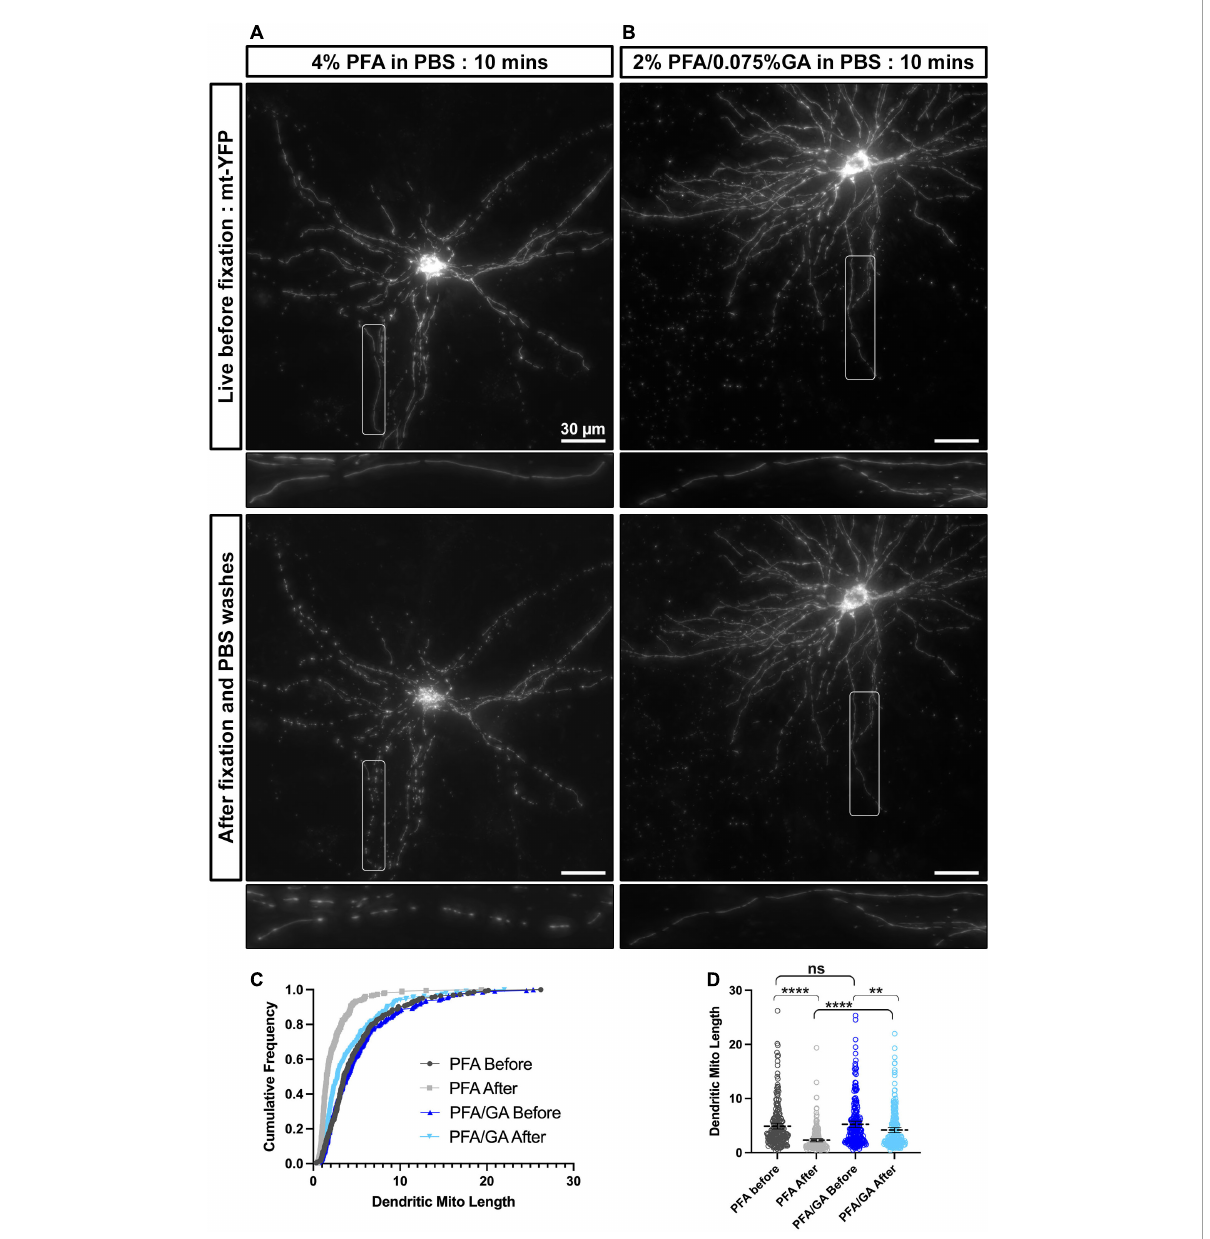
FIGURE1 A combination of PFA and GA maintains mitochondria morphology better than PFA alone in cultured cortical neurons. (A) A representative neuron labeled with mitochondrial matrix targeted YFP (mt-YFP) imaged live before fixation (top) and after fixation with 4% PFA in PBS (bottom) . (B) A representative neuron labeled with mt-YFP imaged live before fixation (top) and after fixation with 2% PFA/0.075% GA in PBS (bottom) . (C) Cumulative frequencies of dendritic mitochondrial length showing that fixation with PFA only results in fragmentation of mitochondria. (D) Quantification of dendritic mitochondrial lengths shown as mean ± 95% CI before and after fixation with the indicated fixative solution. Kruskal–Wallis test with Dunn’s multiple comparisons test. n 4%PFAbefore = 2 cultures, 16 dendrites, 225 mitochondria, n 4%PFAafter = 2 cultures, 16 dendrites, 227 mitochondria, n PFA / GAbefore = 2 cultures, 16 dendrites, 222 mitochondria, and n PFA / GAafter = 2 cultures, 16 dendrites, 238 mitochondria. ** p < 0.01, *** p < 0.001, **** p < 0.0001. Scale bar, 30 µ